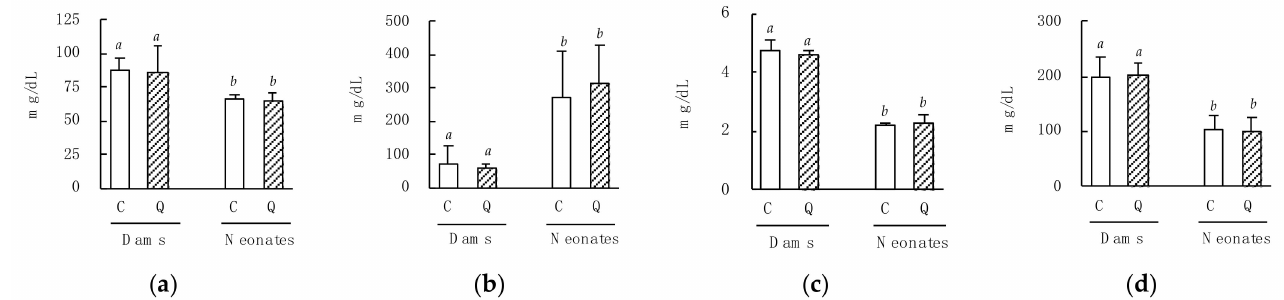
Figure 2. Effects of maternal quercetin consumption during pregnancy on plasma parameters in dams and neonates. After acclimatization on the control (C) diet, the quercetin groups were switched to a diet containing 1.0% quercetin (Q). Breeding was carried out after 3 days on the Q-diet. The C-diet dams and their neonates, as well as the Q-diet dams and their neonates, were sacrificed on postnatal day 3, and then their plasma parameters were analyzed: ( a ) total cholesterol; ( b ) triglycerides; ( c ) total protein; ( d ) glucose. Data are shown as the mean ± SD. Different superscripts ( a , b ) indicate significant differences ( p <